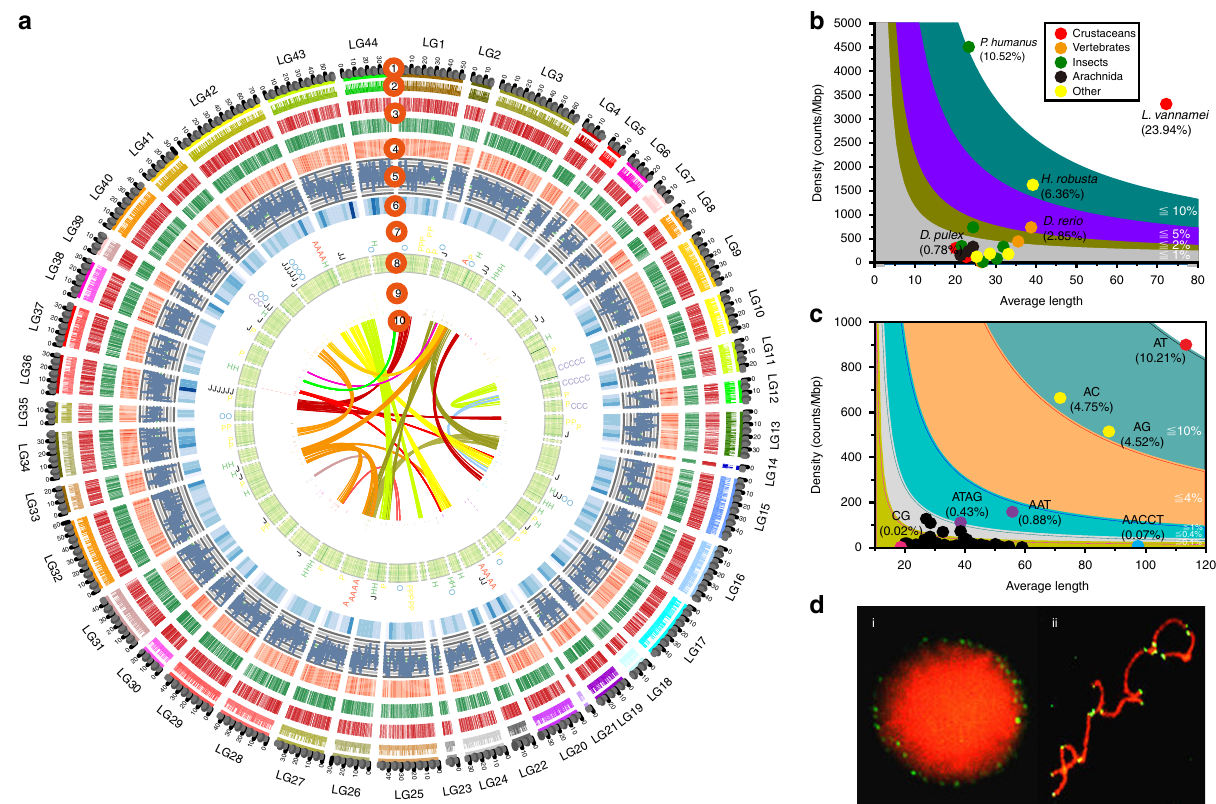
Fig. 1 The genomic characteristics of L. vannamei . a A schematic representation of the genomic characteristics of L. vannamei . Track 1 (from the outer-ring): 44 linkage groups (LGs) of the shrimp genome. Track 2: Scaffolds anchored to each linkage group. Track 3: Protein-coding genes present in the scaffolds. Red represents genes on forward strand and green for genes on reverse strand. Track 4: Distribution of gene density with sliding windows of 1 Mb. Higher density is shown in darker red color. Track 5: Distribution of GC content in the genome. Track 6: Distribution of SNPs density with sliding windows of 5 Mb. Higher density is shown in darker blue color. Track 7: Distribution of six signi fi cantly expanded gene families in the genome, which are opsin (O), peritrophin-like protein (P), chitinase (H), calci fi ed cuticle protein (A), crustacyanin (C), and JHE-like carboxylesterase 1 (J). Track 8: Distribution of SSRs in the genome. Higher density of SSRs is shown with deeper color. Track 9: Distribution of miRNA in the genome. Clusters of co-transcribed miRNAs at adjacent positions are displayed in stacked style. Track 10: Schematic presentation of major interchromosomal relationships in the shrimp genome. b SSR content among different animal genomes. c Distribution of different types of SSRs in the L. vannamei genome. d Fluorescence in situ hybridization (FISH) of (AACCT) n type SSR to the nucleus (i) and the chromosomes (ii) of L. vannamei. SNP single nucleotide polymorphism, SSR simple sequence with (AT) n , (AC) n , and (AG) n accounting for 81.40% of total SSRs (Fig. 1c, Supplementary Fig. 5). Most SSRs were located in intergenic regions (24.63%) and introns of protein-coding genes (22.07%), and far fewer were found in exons (1.41%). (AACCT) n , a telomere component identi fi ed by fl uorescence